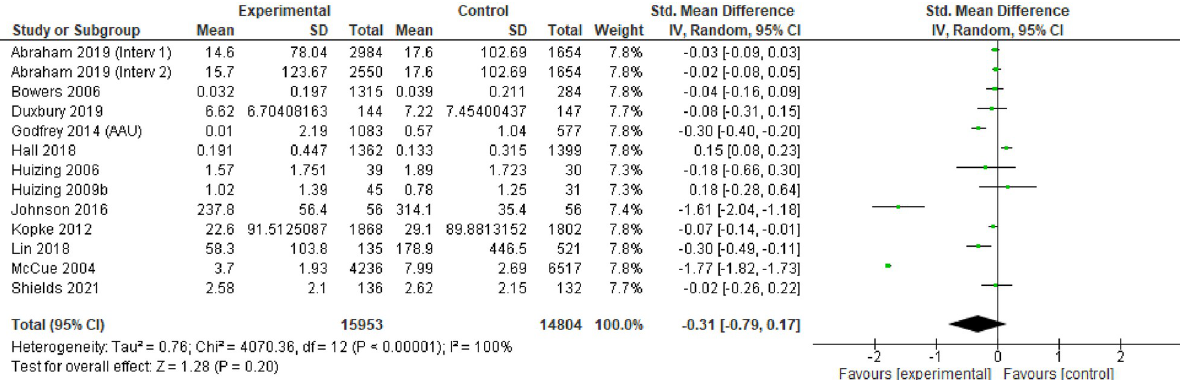
Fig 4. Effectiveness of interventions on the use of restraint, excluding outliers.